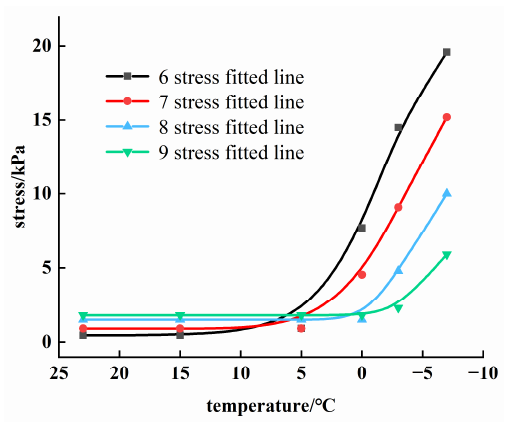
Figure 10. Horizontal stress curve.